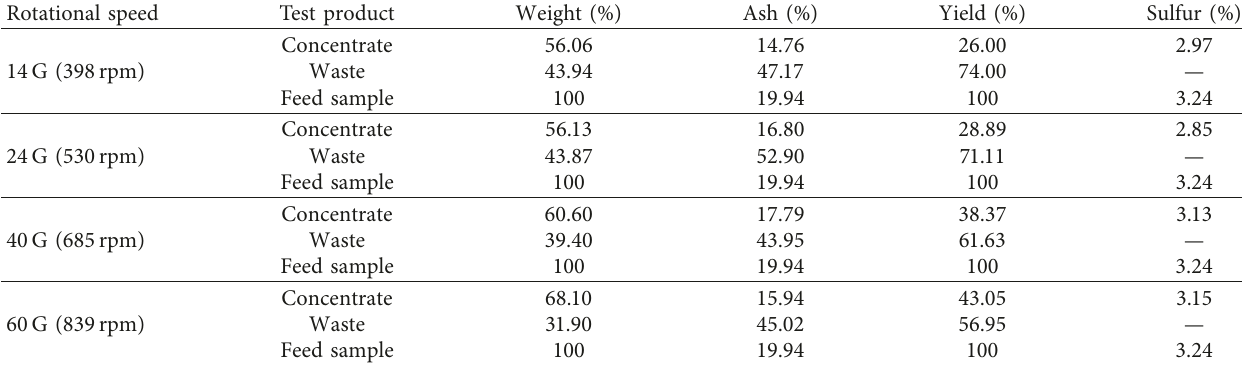
Table 10: Enrichment concentration values of Sample-C1 coal with Knelson method (